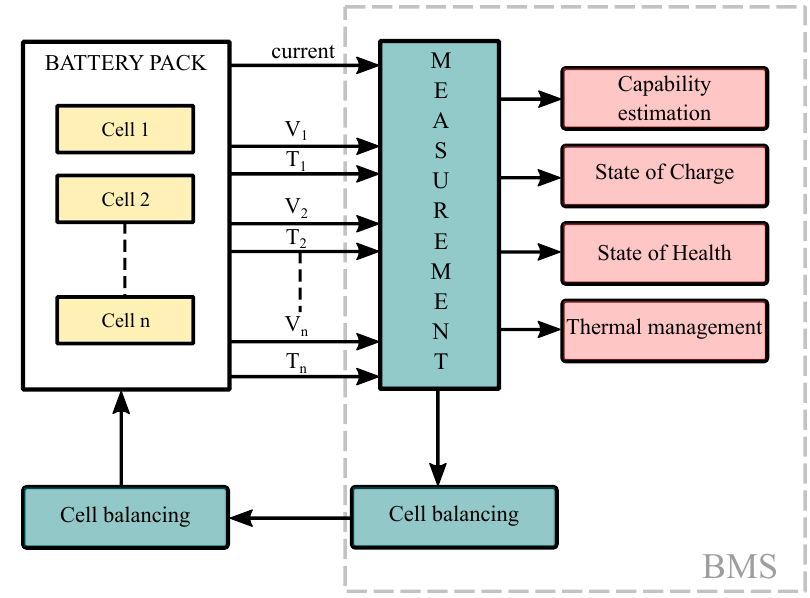
Figure 9. Scheme of battery pack and BMS system [26].